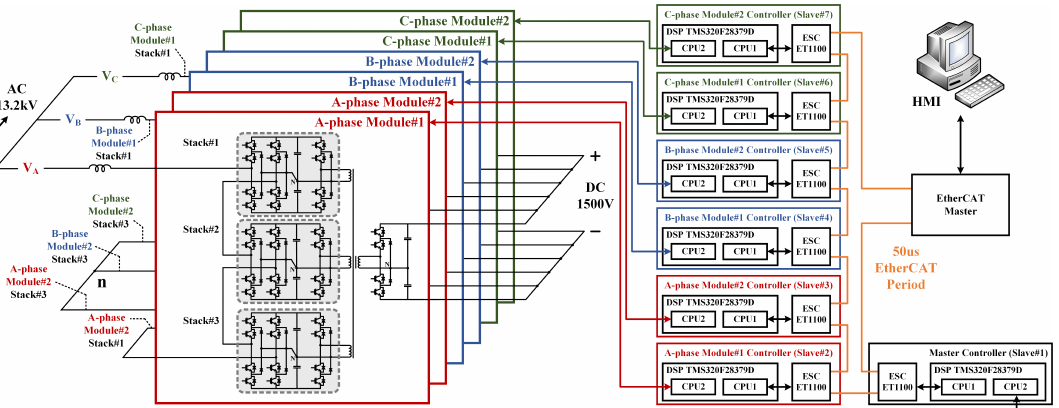
Figure 5. The structure of the proposed 3-phase solid-state transformer based on EtherCAT